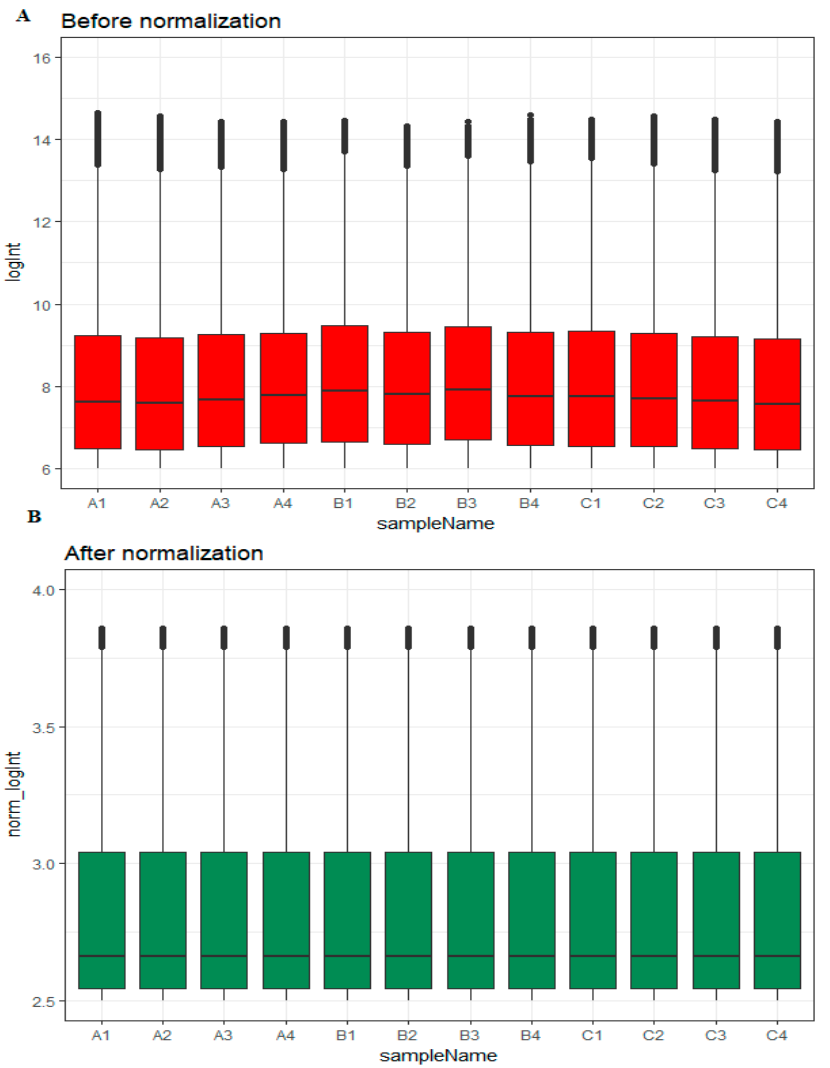
Figure 1. Box plots of the expression profiles. ( A ): Before normalization (red) and ( B ): after normalization (green). (A1, A2, A3, A4 = high-grade ovarian epithelial cancer, B1, B2, B3, B4 = normal fallopian tube samples, C1, C2, C3, C4 = normal ovarian epithelium samples).